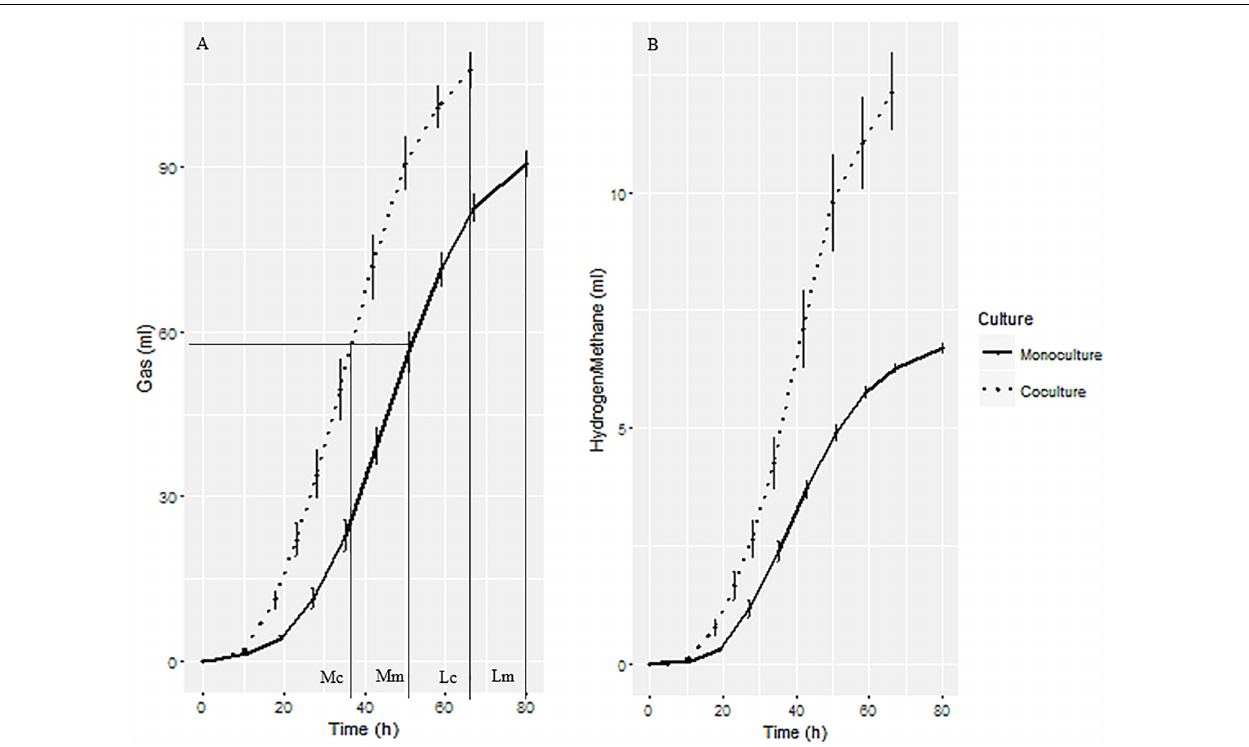
FIGURE 1 | Gas production of anaerobic fungal monoculture and fungal-methanogen co-culture. (A) Cumulative gas production curve showing the sampling time for transcriptomic, proteomic, and fermentation end products analysis. Mc, mid-growth stage of co-culture; Mm, mid-growth stage of monoculture; Lc, late-growth stage of co-culture; Lm, late-growth stage of monoculture. (B) H 2 and CH 4 production from fungal monoculture and co-culture, respectively.